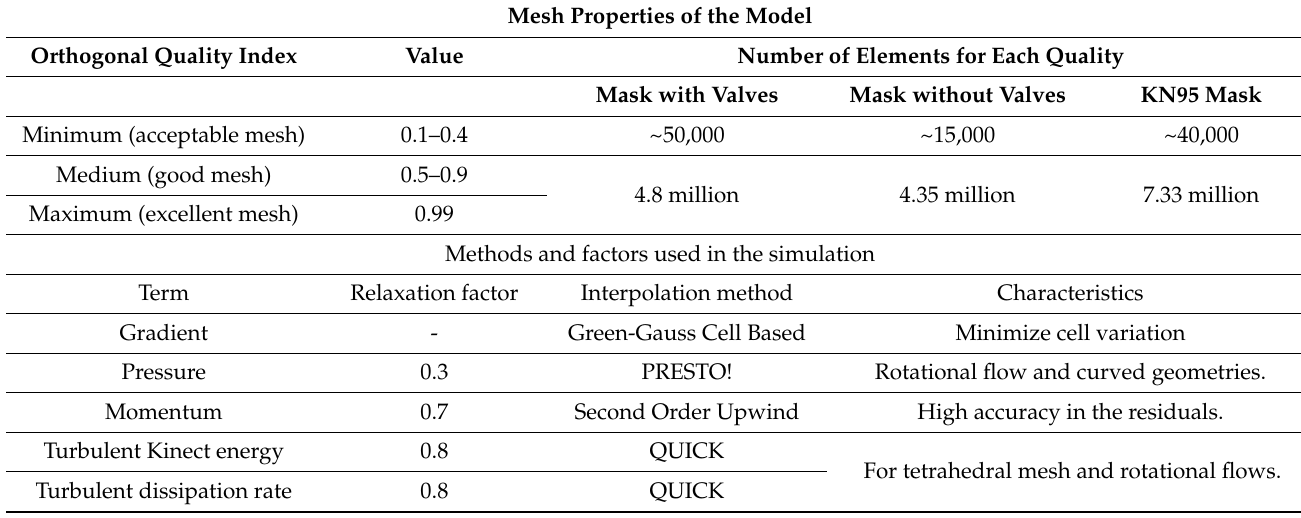
Table 2. Parameters and values for mesh and setup for the simulation. Mesh Properties of the